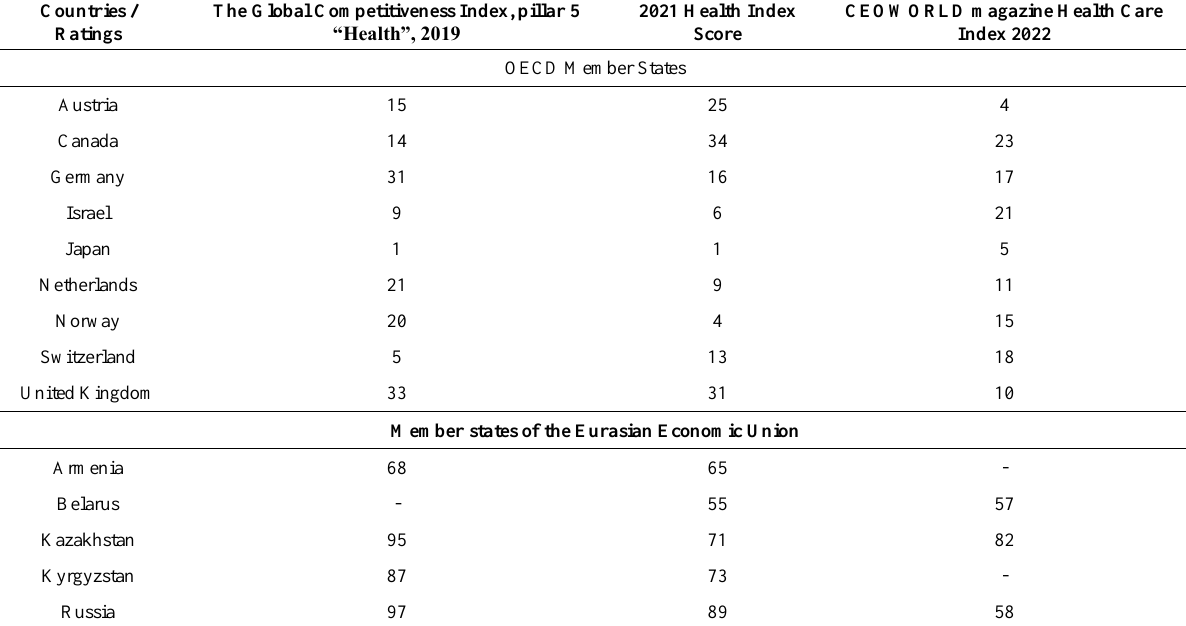
Table 2. Positions of some OECD and EAEU states in international rankings of healthcare